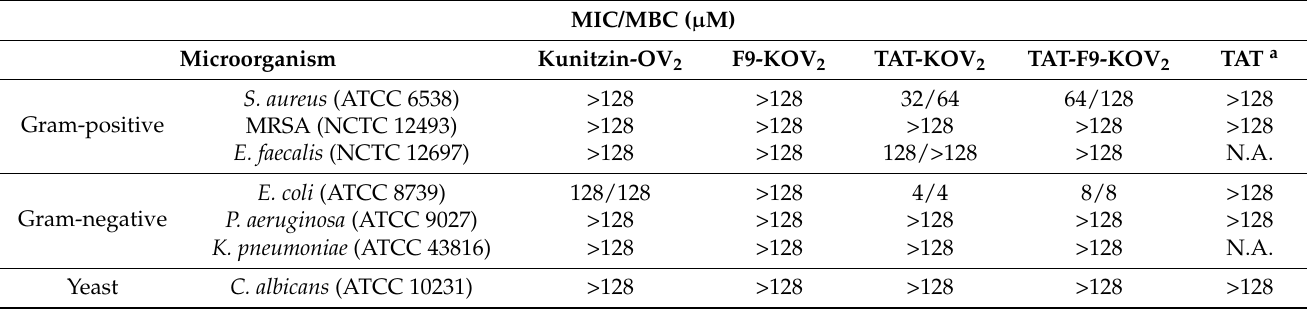
Table 3. MIC/MBC of kunitzin-OV 2 and its relatives against different microorganisms.